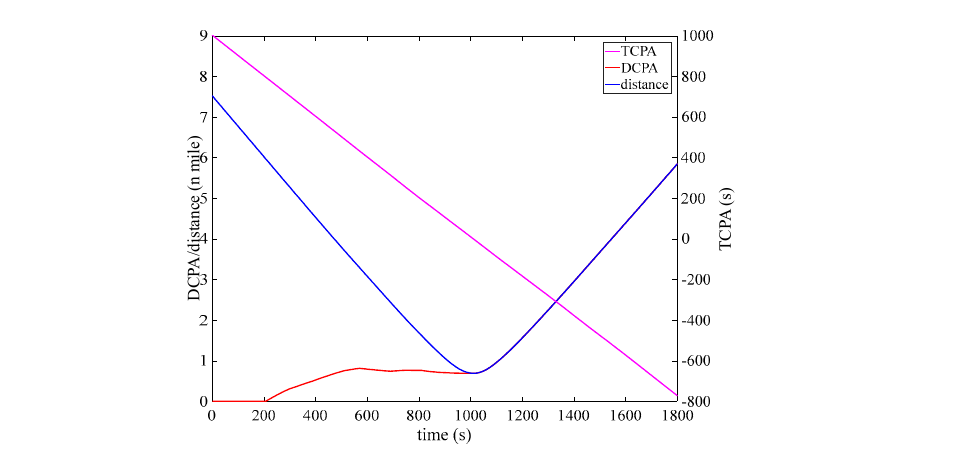
Figure 18. The curve of ship encounter parameters varies with time in head-on situation.